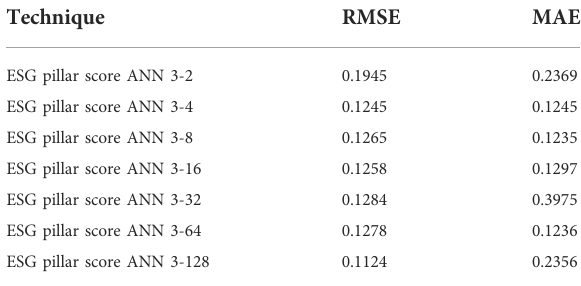
TABLE 6 Result of ESG pillar score error measurement using hidden layer 3 with 2, 4, 8, 16, 32, 64, and 128 neurons.